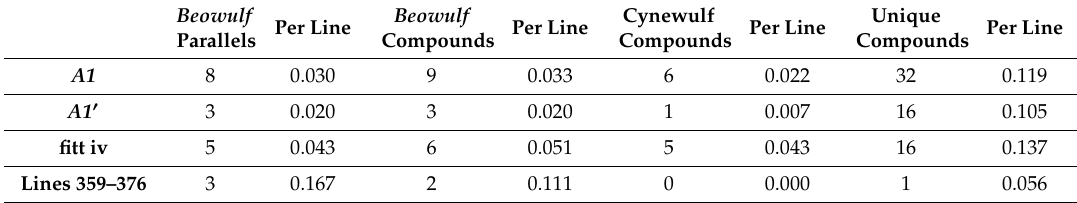
Table 3. Distribution of word compounds in the section A1